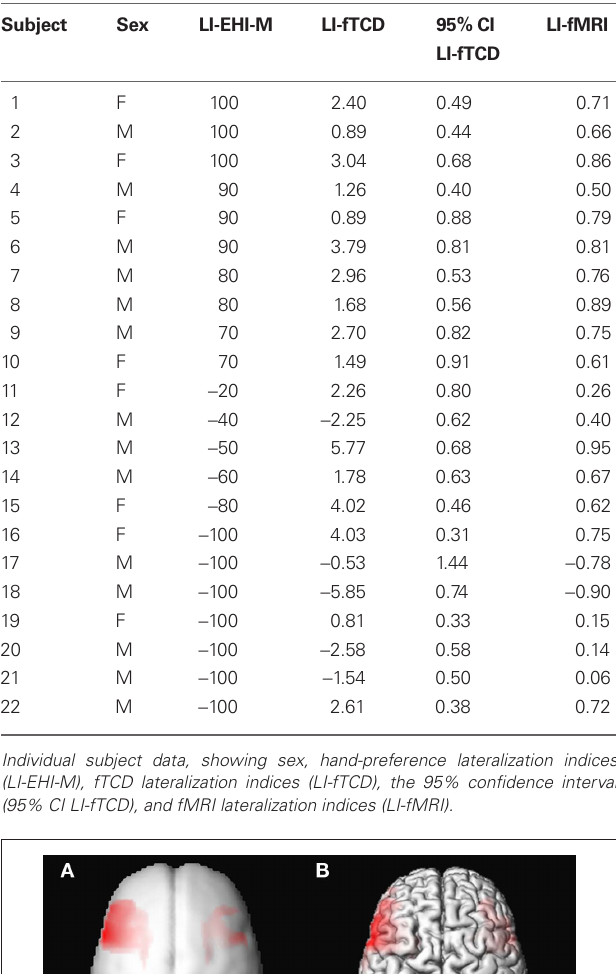
Table 1 | Lateralization indices of all subjects.